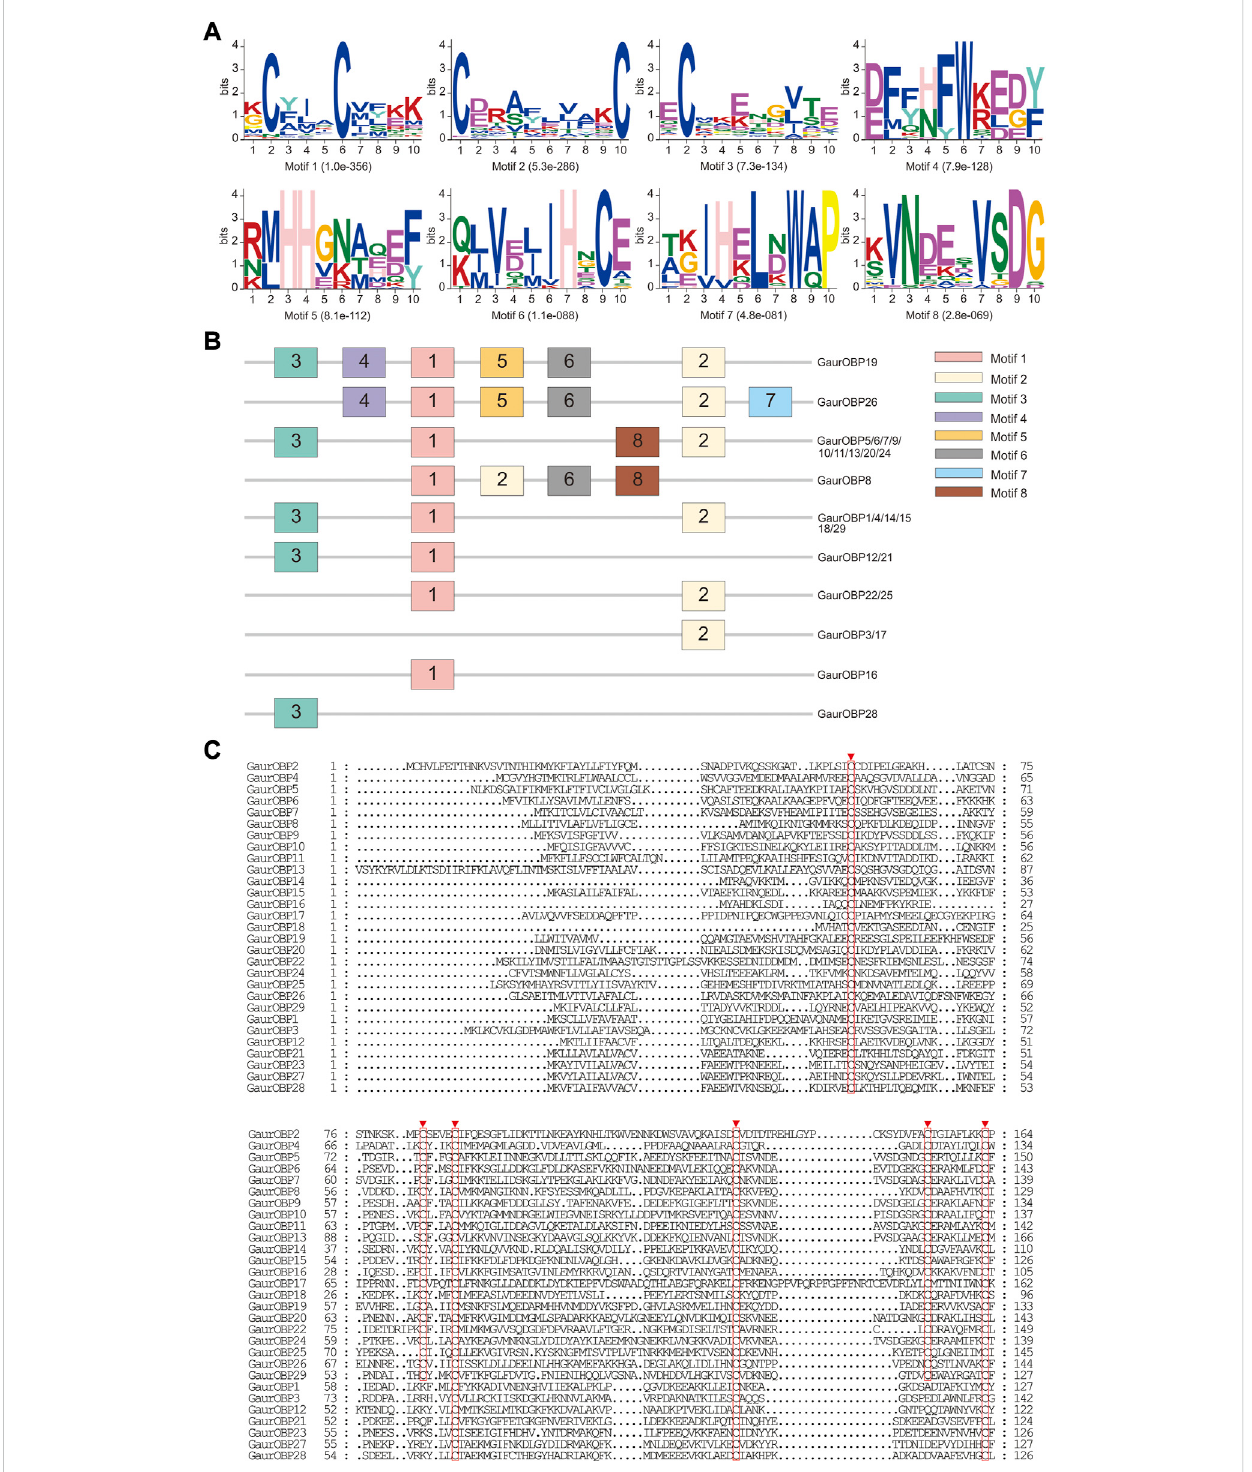
FIGURE 4 Motif pattern analysis and alignment of candidate odorant-binding proteins (OBPs) of Gynaephora aureata . (A) Eight motifs from G. aureata and otherlepidopterans.The E -valueforeachmotifisshowninparentheses. (B) Locationsofeachmotifintheproteinsequences. (C) Alignmentofcandidate OBPs of G. aureata . Highly conserved cysteine residues are marked with red